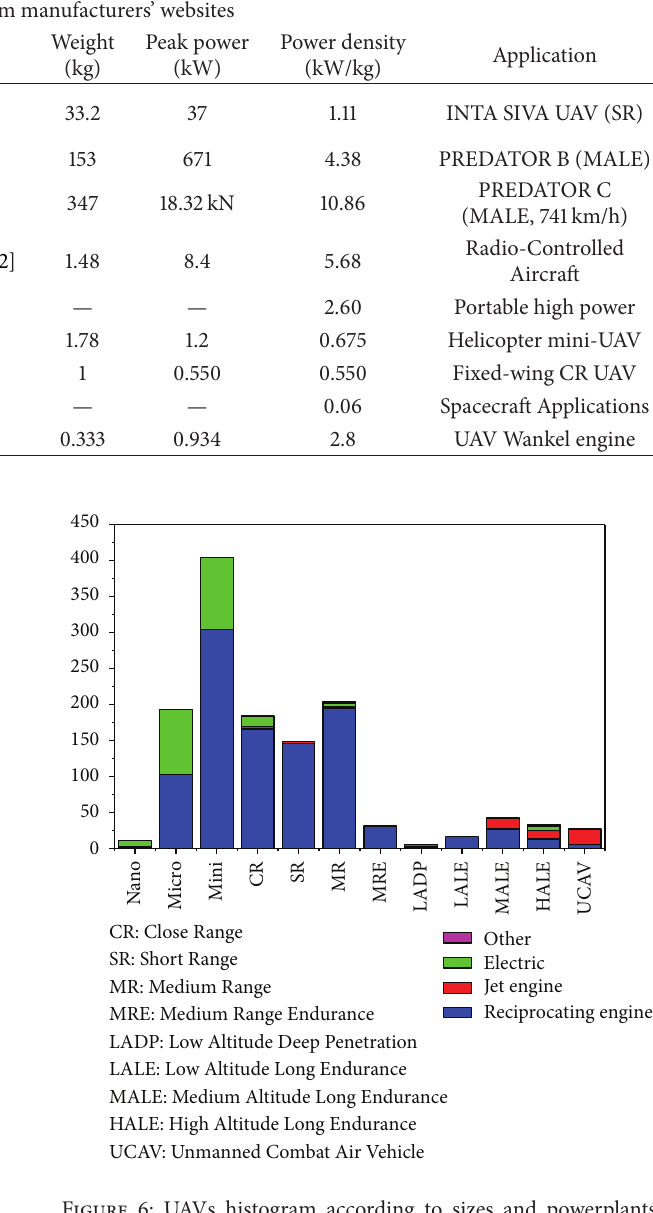
Figure 6: UAVs histogram according to sizes and